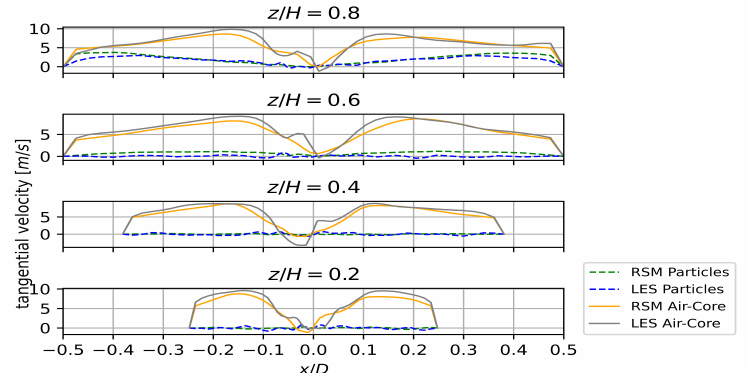
Figure 19. Tangential velocities (m/s) as a function of the normalised x co-ordinate at various heights at flow-time 4 s for the simulations with the particles included and at flow-time 2 s for the air-core only